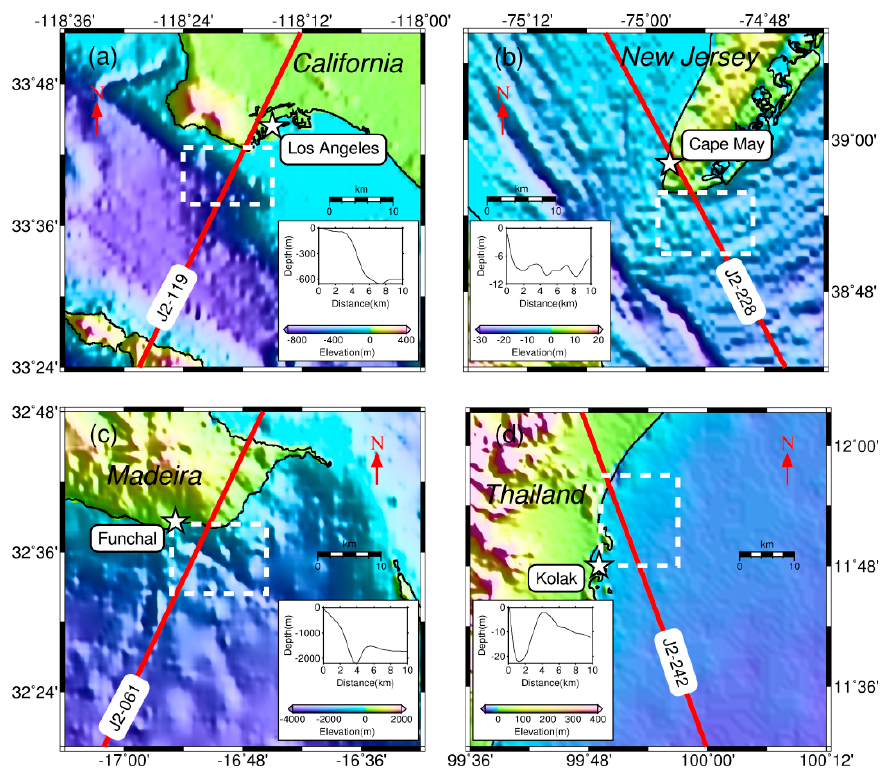
Figure 1. Study regions: ( a ) Los Angeles, CA, USA; ( b ) Cape May, NJ, USA; ( c ) Funchal, Madeira Island, Portugal; ( d ) Ko Lak, Prachuap Khiri Khan, Thailand. Red line denotes ground track of Jason-2 satellite. Orientation of the pass tag over the red line implies flight direction of the satellite. Evaluated data are located within the rectangle with the white dashed line. Gauge station is marked as the white pentacle with black edge. Topography is extracted from the digital elevation model SRTM30-plus [51]. Interpolated along-track ocean depth within 0–10 km offshore is plotted in the sub-panel.